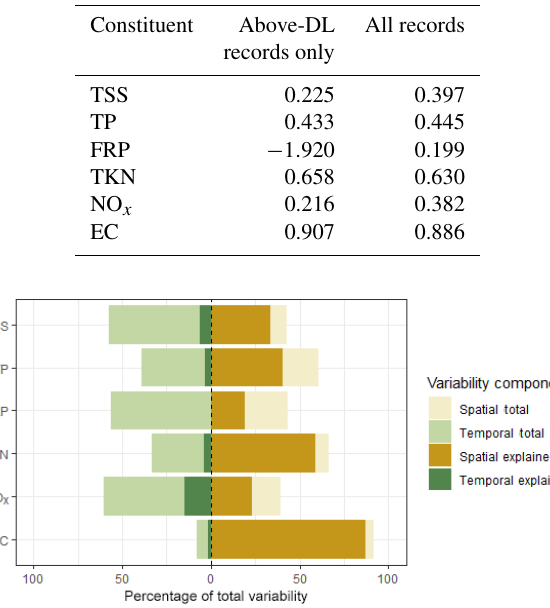
Figure 3. Observed spatial and temporal variabilities as propor- tions of the total variability (the total width of each bar is 100%). The dashed line differentiates temporal variability (left) from spatial variability (right), and the darker colors highlight the proportions of the spatial and temporal variabilities that are explained by the model. All values were estimated in Box–Cox-transformed space.